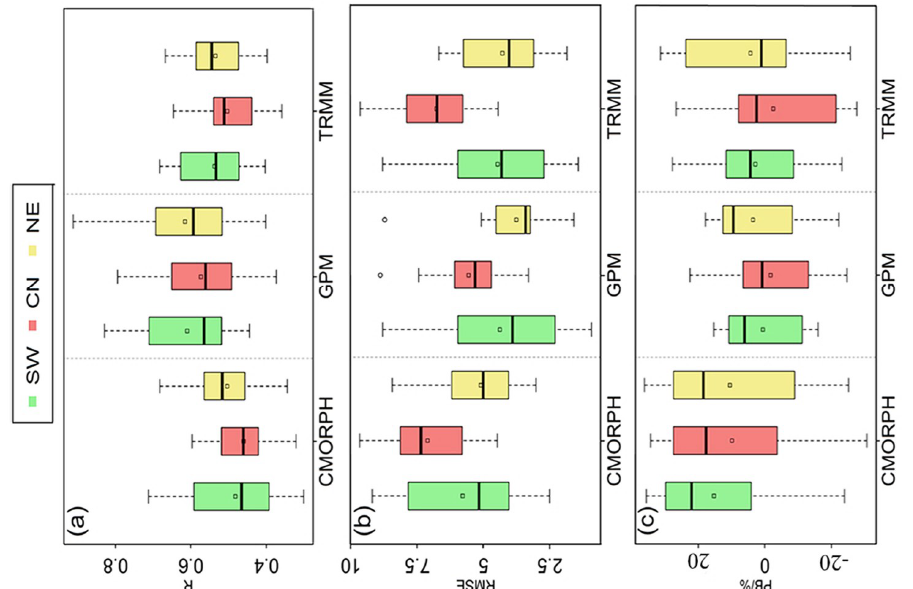
Figure 5. Results of the different accuracy estimators for each satellite-based product in different sub-regions. The statistical metrics are ( a ) Pearson linear correlation coefficient, ( b ) root-mean-square error, and ( c ) relative bias. In the box plot, the solid black line represents the median value, the square represents the average value, and the four horizontal lines from top to bottom are the upper edge line, upper quartile, lower quartile, and lower edge, respectively, and the hollow black point represents the